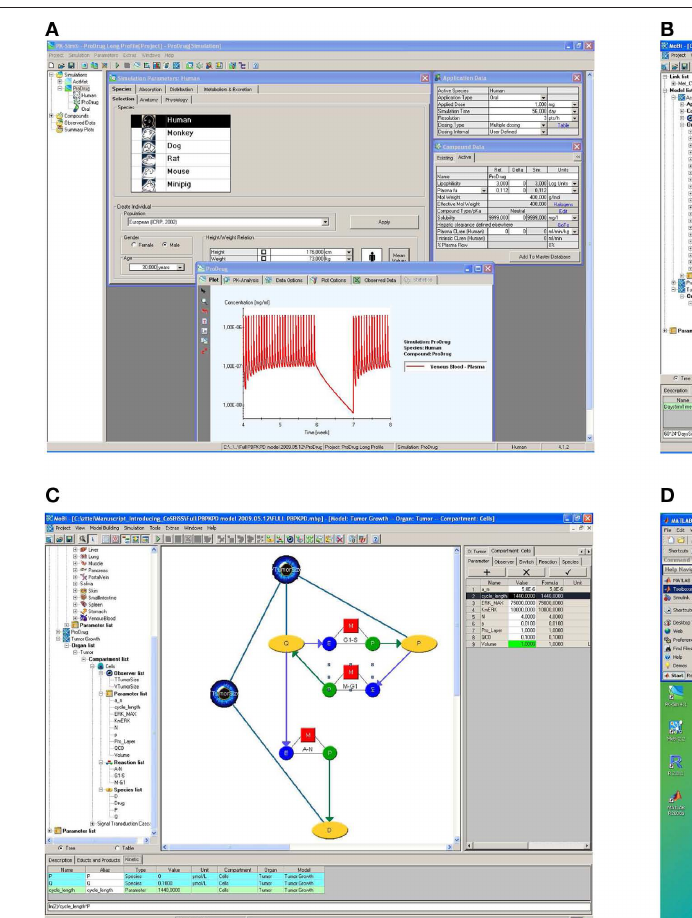
whole body level. (C) MoBi ® screenshot at the sub-compartment level. (D) MATLAB ® help and GUI screenshot to assist in code generating for MoBi ® model processing. Additional details describing the four subfigures as well as enlarged versions of these are available as Supplementary